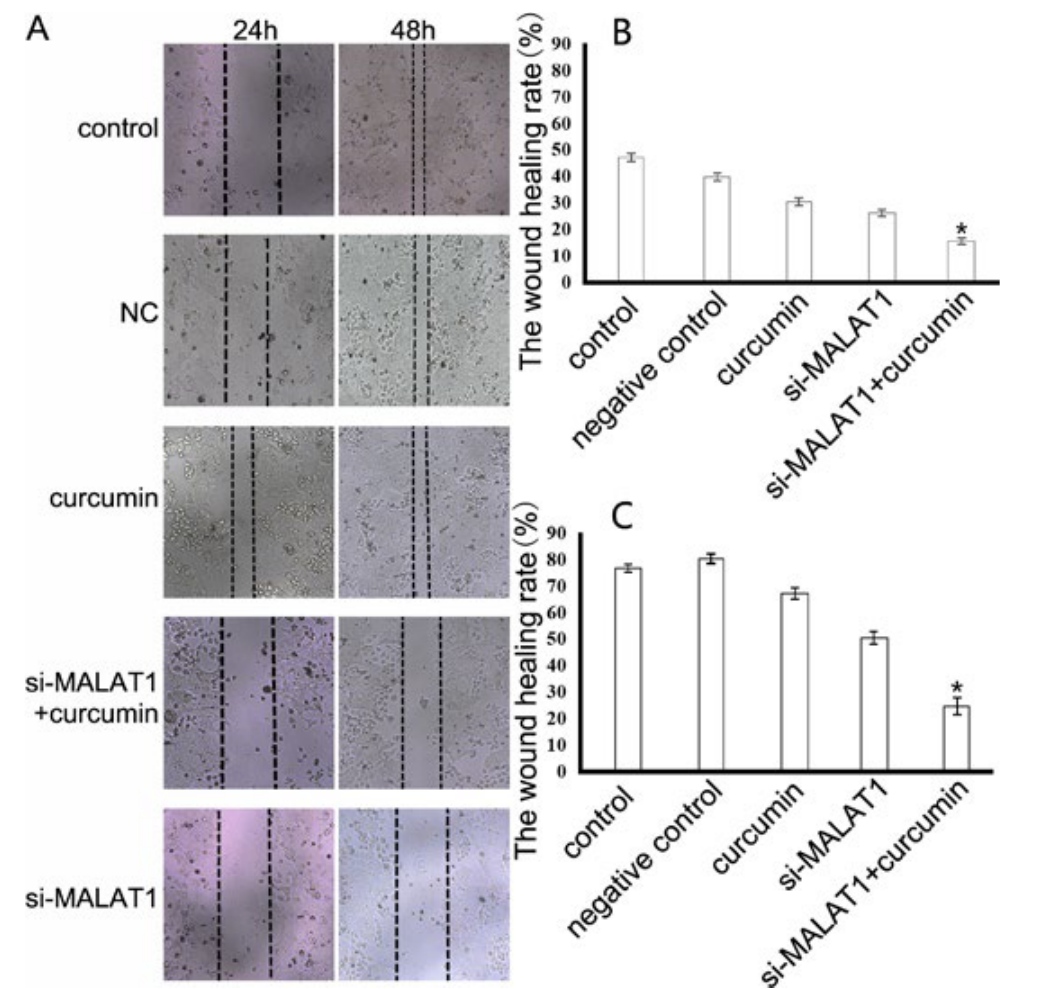
FIGURE 4 - The invasion ability of SW480 cells in different groups was evaluated by scratch-wound assay. A: The invasion cells in each group were observed under fluorescence microscope (40X; B: The quantitative analysis of the invasion cells in each group: 1: Control group; 2: Negative control group; 3: Curcumin group; 4: si-MALAT1 group; 5: Curcumin combined with si-MALAT1 group. Mean ± SD. n =3 . * P <0.05 vs other groups.